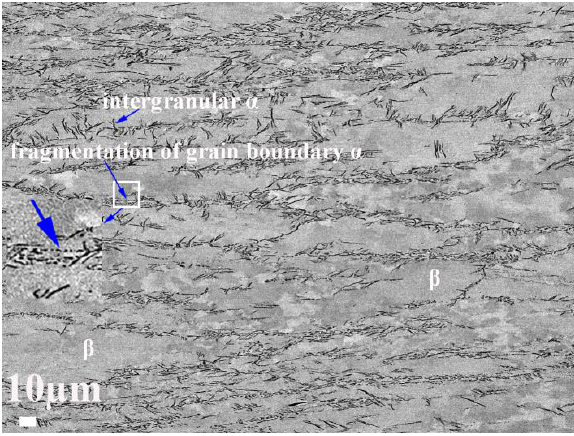
Figure 3. Secondary electron FE-SEM image showing a general view of the microstructure. Due to the breaking up the lamellar α acting as barriers to the dislocations, flow softening occurs Figure 3. Similar formation of equiaxed β subgrains of ~5 µm size was reported after compression deformation of 1023 alloy at 760 °C and 10 −2 s −1 strain rate [31].